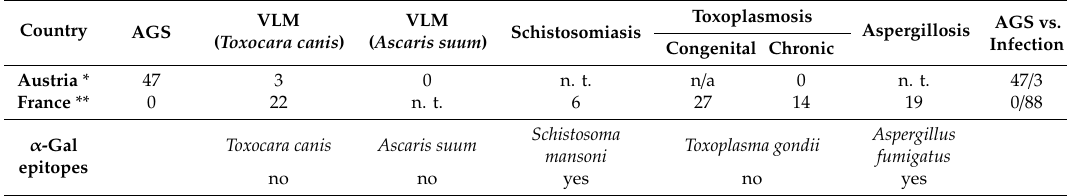
Table 1. The number of tested and reactive sera collected from patients with α -Gal syndrome (Austria) and those infected with parasites and fungi (France). Expression of terminal α -Gal moieties in targeted organisms as observed by immunoblot, immunofluorescence, and flow cytometry.